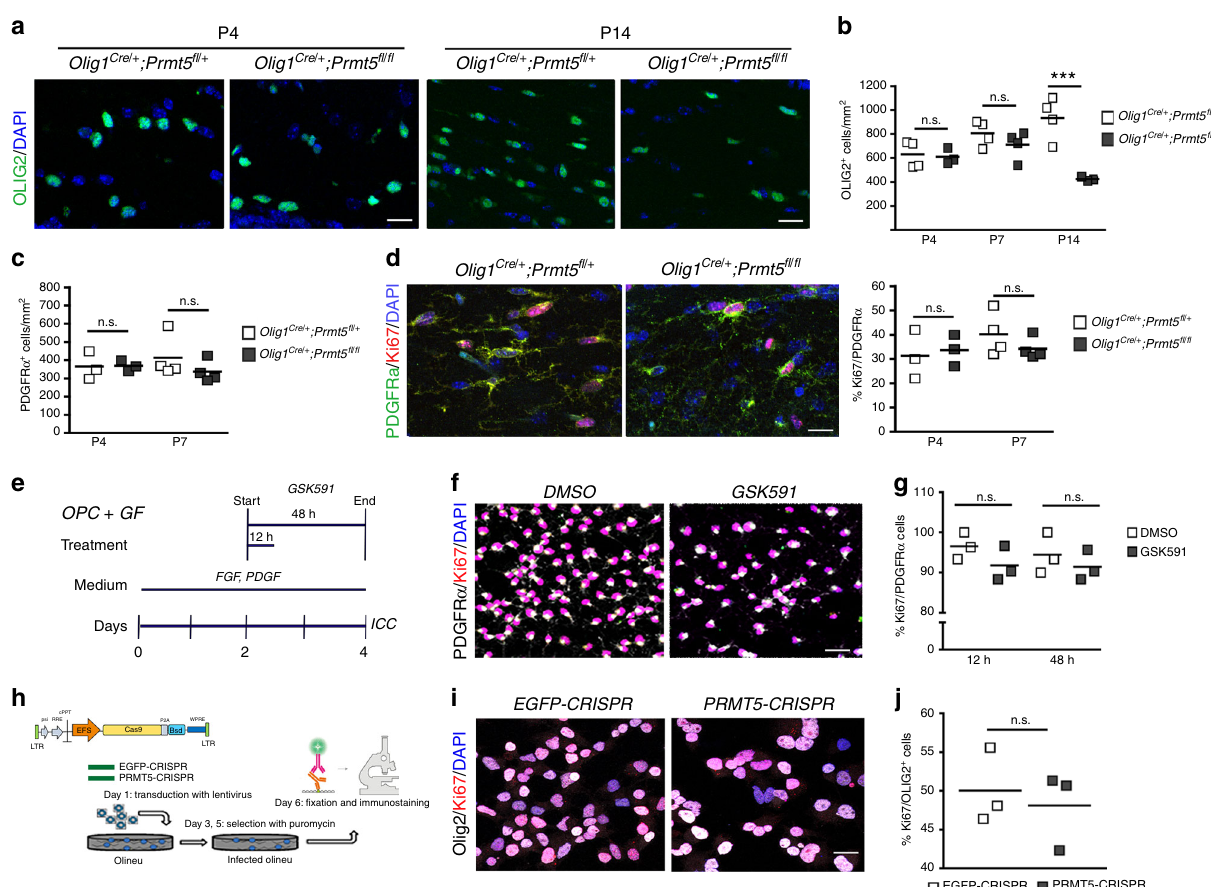
Fig. 3 Reduced OPC number in the absence of Prmt5 is independent of proliferation. a Representative confocal images of P4 and P14 corpus callosum from controls ( Olig1 Cre/ + ; Prmt5 fl / + ) and Prmt5 mutants ( Olig1 Cre/ + ; Prmt5 fl / fl ) stained for OLIG2 (green) and DAPI (blue). Scale bar: 20 μ m. b , c Quanti fi cation of total ( b ) OLIG2 + or ( c ) PDGFR α + cell numbers per unit area in the corpus callosum of three (P4 and P14) or four (P7) mutants and four controls at the indicated time points. One-way ANOVA with Bonferroni ’ s multiple comparison test, *** p < 0.001. d Confocal images of corpus callosum from controls ( Olig1 Cre/ + ; Prmt5 fl / + ) and Prmt5 mutants ( Olig1 Cre/ + ; Prmt5 fl / fl ) stained for PDGFR α (green) KI67 (red), and DAPI (blue). Scale bar: 20 μ m. Scatter plots represent the average cell counts in three mice for each genotype at P4 and four mice at P7. One-way ANOVA with Bonferroni ’ s multiple comparison. e Schematics of the experiment with the PRMT5 pharmacological inhibitor, GSK591. f Representative confocal images of DMSO-treated or GSK591-treated OPCs stained for PDGFR α (white), KI67 (red), and DAPI (blue). Scale bar: 20 μ m. g Quanti fi cation of proliferating OPC (KI67 + PDGFR α + ) from three biological replicates (one-way ANOVA). h Schematic representation of CRISPR knockdown experiment. i Representative confocal images of control (EGFP- CRISPR) and knockdown (PRMT5-CRISPR) OliNeu cells stained with antibodies speci fi c for OLIG2 (white), KI67 (red), and DAPI (blue). Scale bar: 20 μ m. j Quanti fi cation of KI67 immunoreactivity measured in at least 50 OLIG2 + cells from three biological replicates. Scatter plots indicate values relative to the average of the EGFP-CRISPR group (Student ’ s t test). n.s. nonsigni